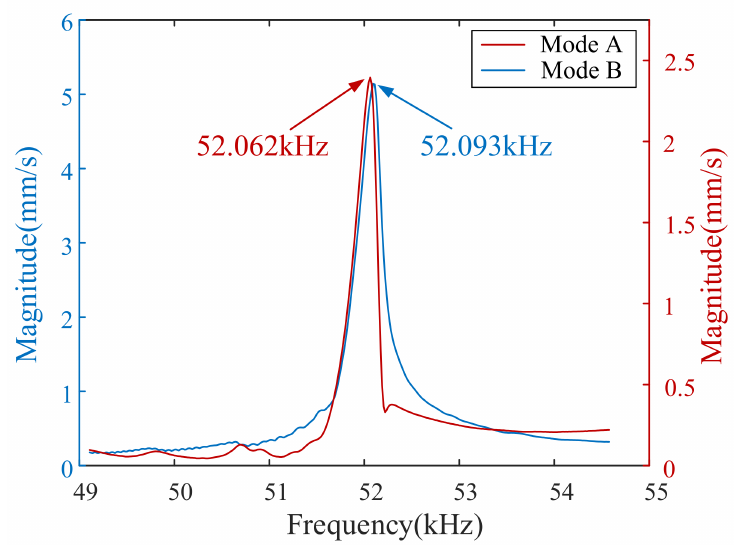
Figure 9. Measured vibration velocity response spectrum.